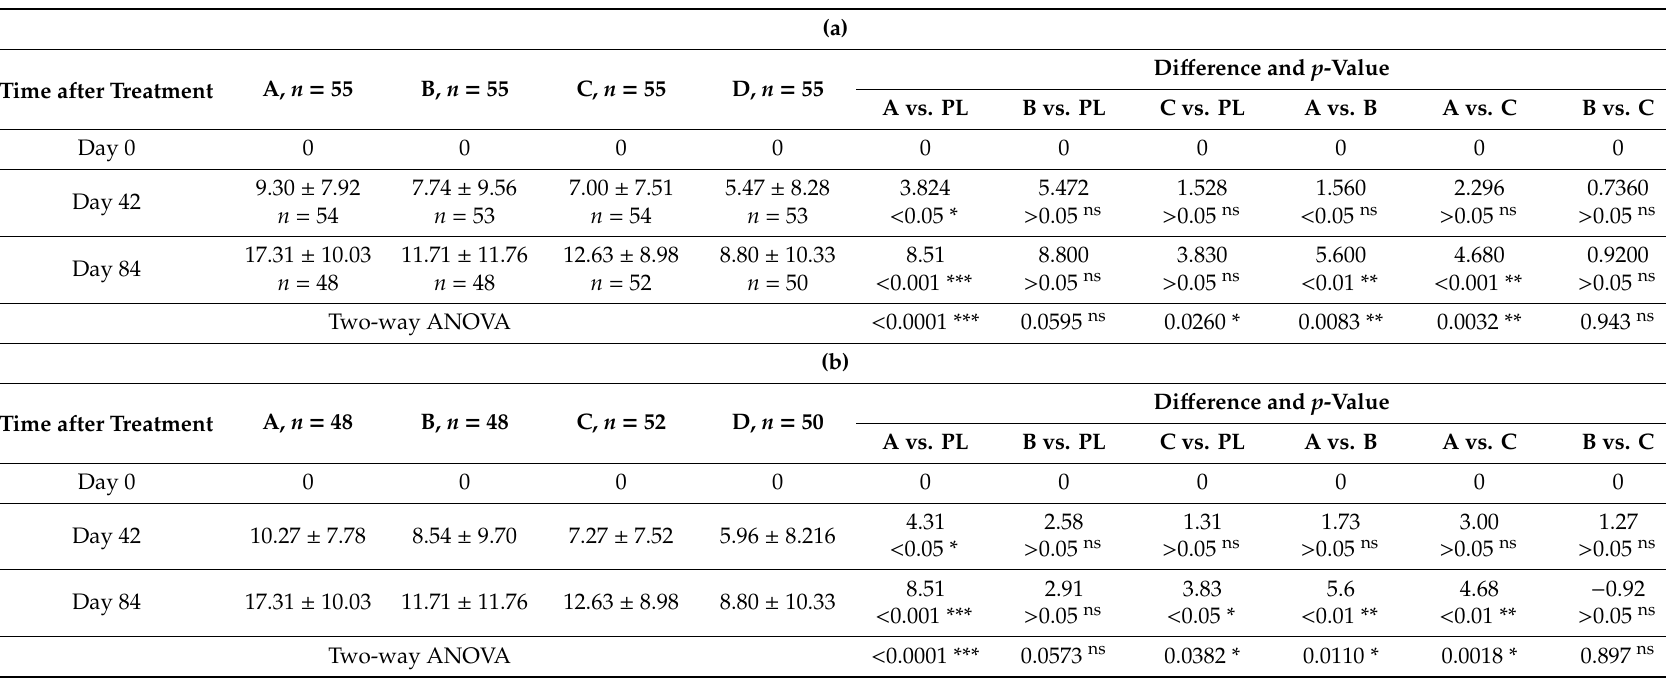
Table A4. ( a ). The change from baseline of UQOL score (mean ± SD) over time. All patients including dropouts—ITT analysis. ( b ). The change from baseline of UQOL score (mean ± SD) over time. Patients completed the treatment and all tests, dropouts excluded—PP